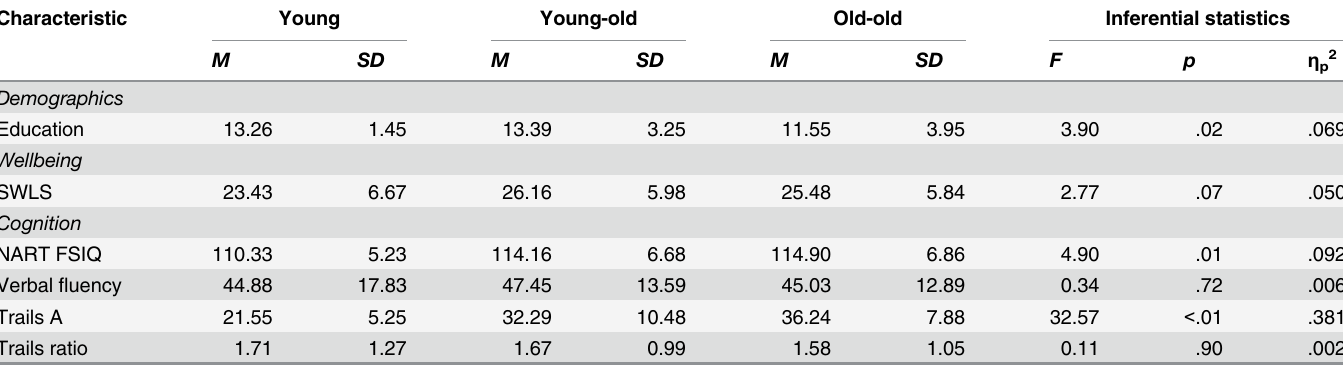
Table 1. Background characteristics of the three groups (younger, young-old and old-old adults).